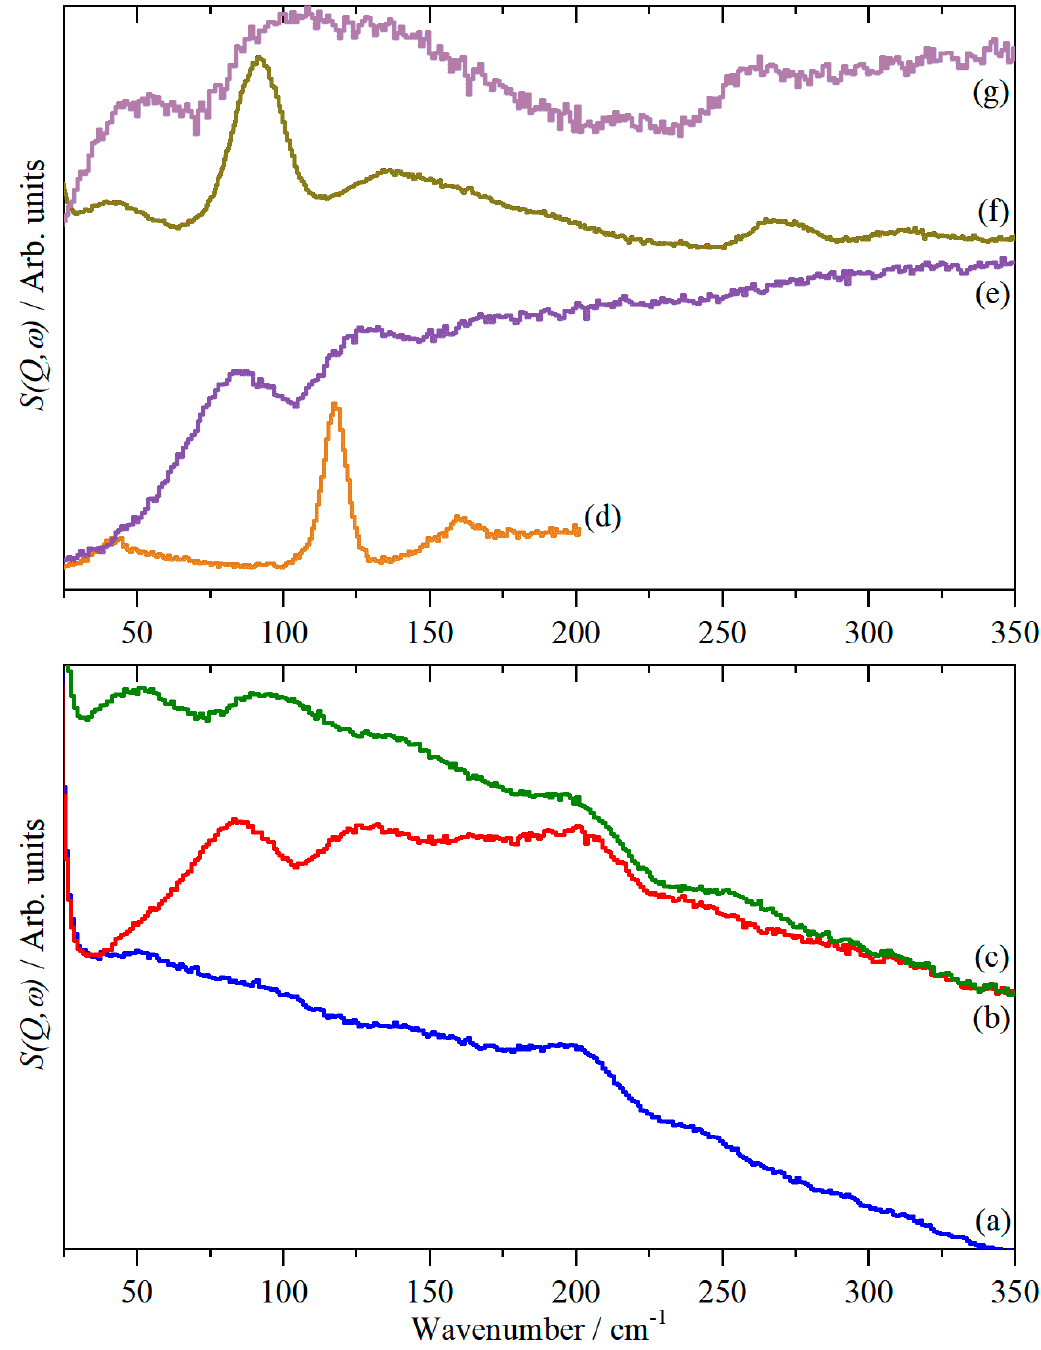
Figure 3. Inelastic neutron scattering (INS) spectra at 7 K in the low energy region ( E i = 400 cm − 1 ) of ( a ) clean Fe-BTC, ( b ) Fe-BTC + H 2 , ( c ) Fe-BTC + HD, ( d ) solid H 2 ( E i = 240 cm − 1 [21]), ( e ) difference spectrum ((Fe-BTC + H 2 )-(clean Fe-BTC)), i.e., ( b – a ), ( f ) solid HD and ( g ) difference spectrum ((Fe-BTC + HD)-(clean Fe-BTC)), i.e., ( c – a ). ( e ) is ordinate expanded × 1.1 and ( g ) × 2 relative to ( a ), ( b ) and ( c ).